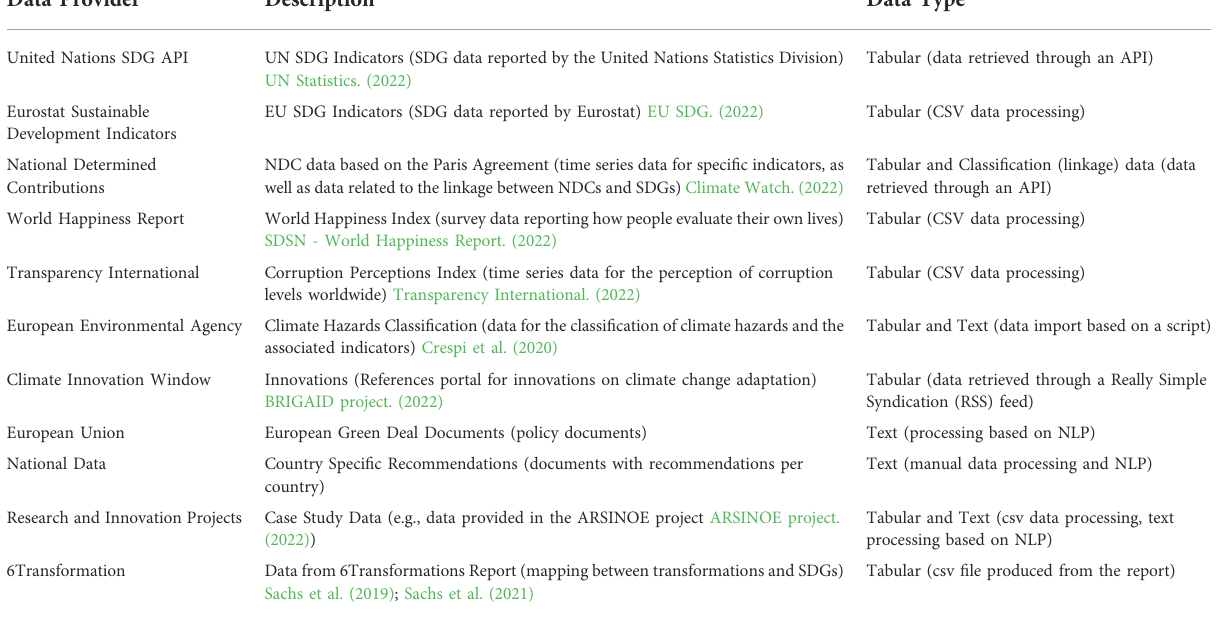
TABLE 1 Indicative Data sources for the SustainGraph data